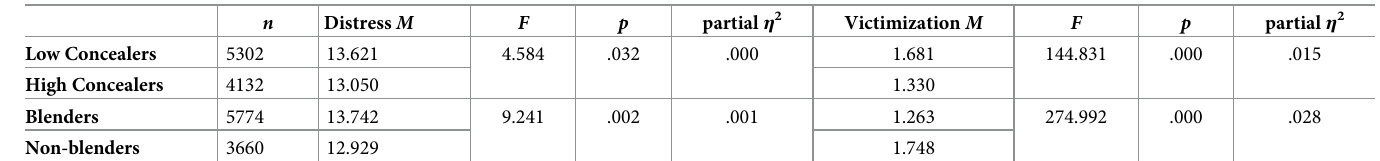
Table 4. Univariate tests